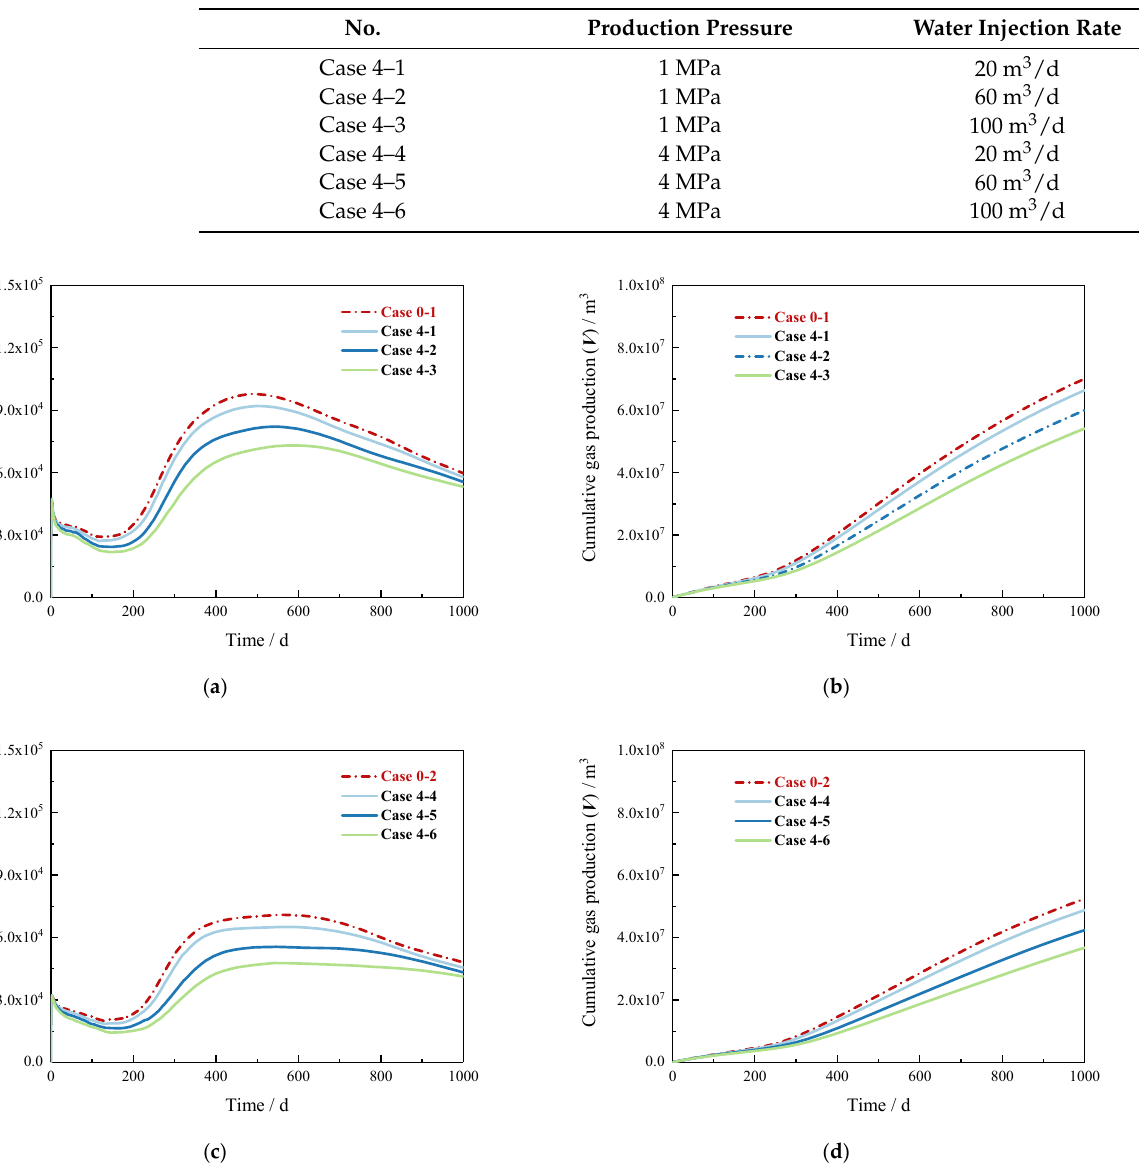
( b ) Figure 12. Energy efficiency characteristics for the depressurization combined thermal stimulation: ( a ) P = 1 MPa; ( b ) P = 4 MPa. 5. Conclusions and Suggestions